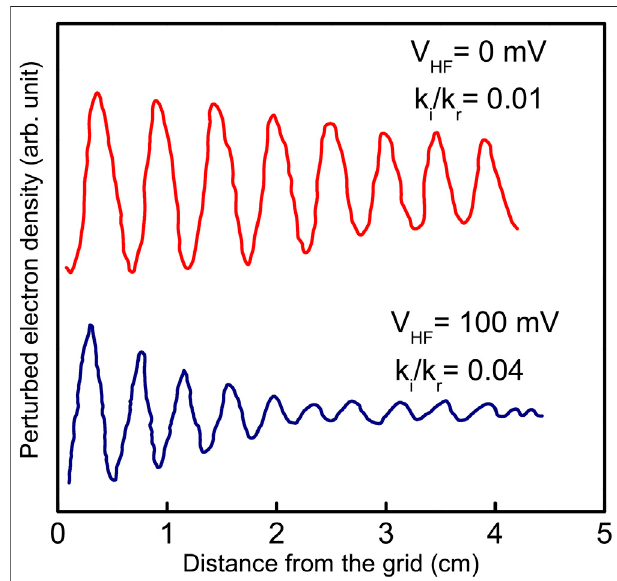
FIGURE 1 | Block diagram of the experimental arrangement to enhance theLandaudampingaswellasmeasurethedispersionrelationofionacoustic waves.